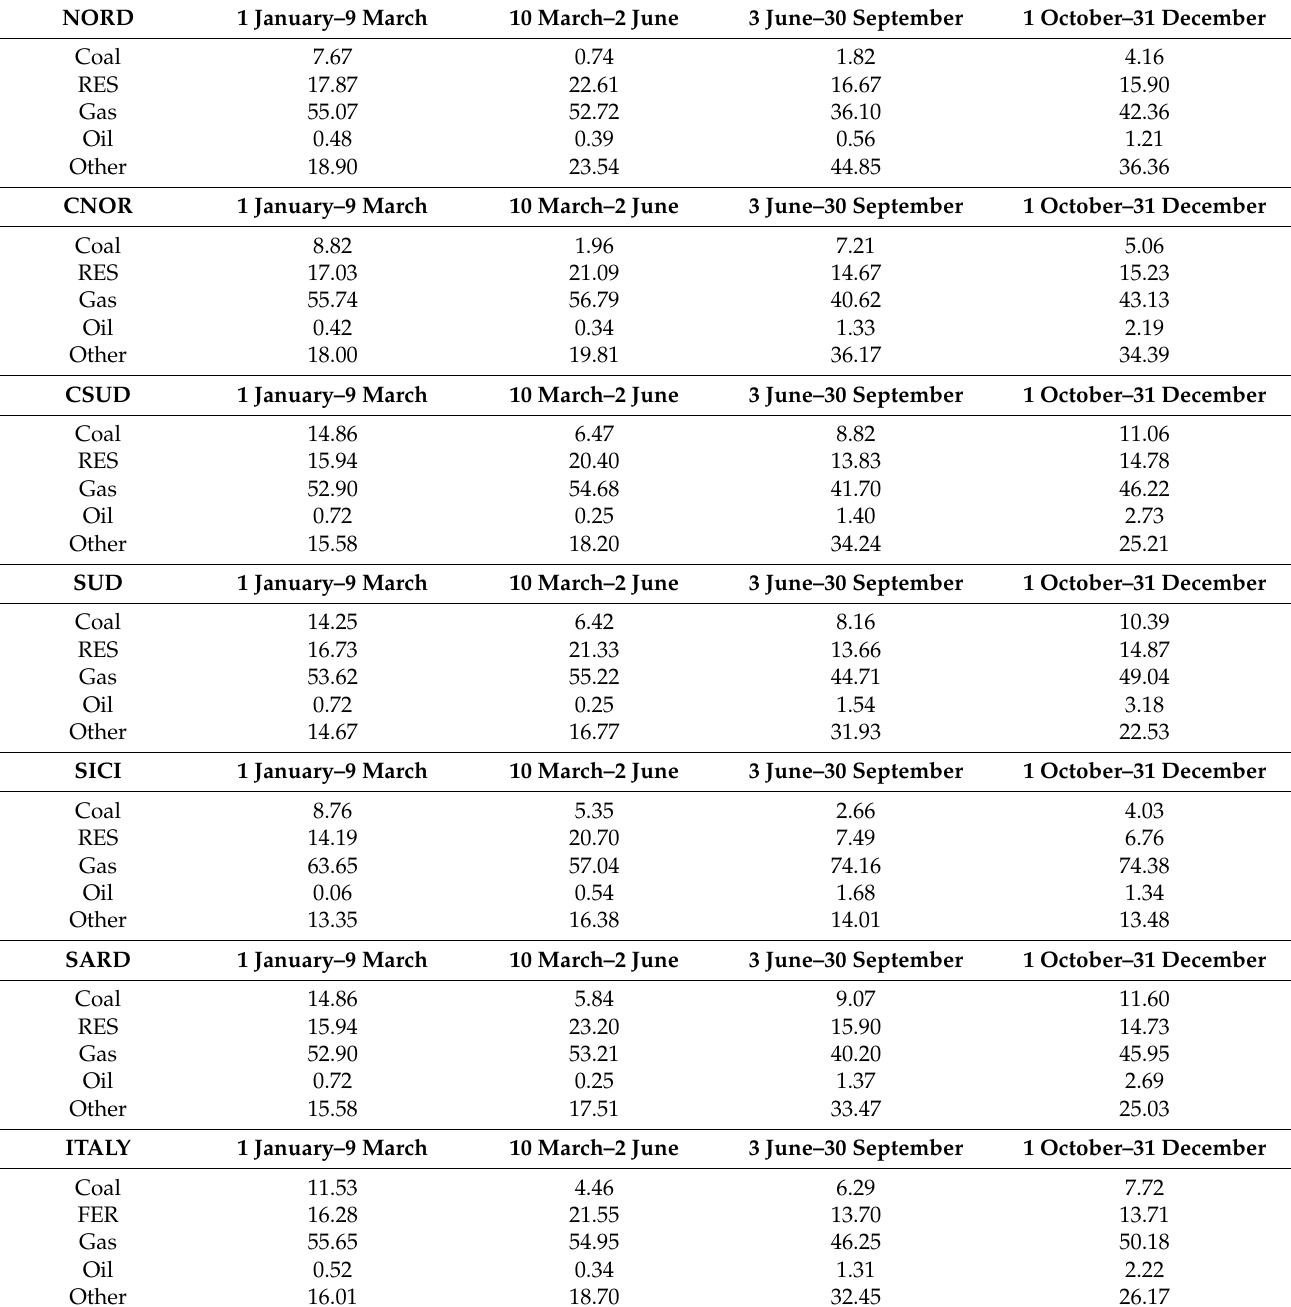
Table 10. Average Frequency of Marginal Technology According to the Different Periods of